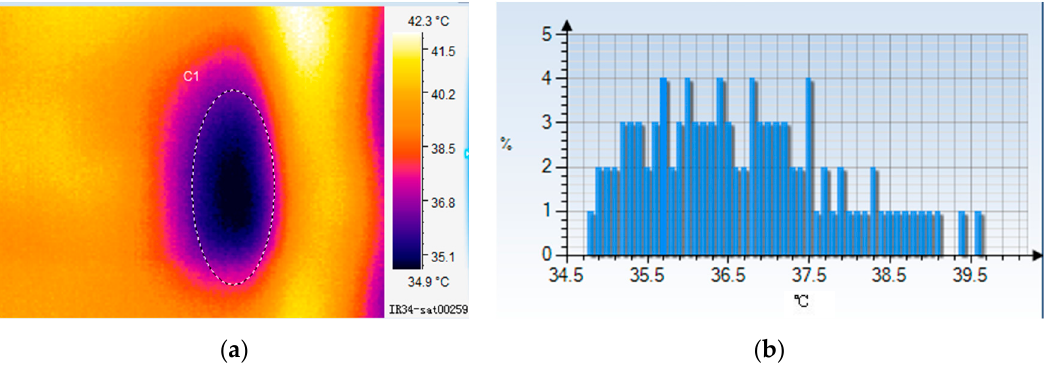
Figure 10. Infrared imaging and temperature distribution after irrigation at 11:50 a.m., ( a ) Infrared imaging; ( b ) Temperature distribution diagram.